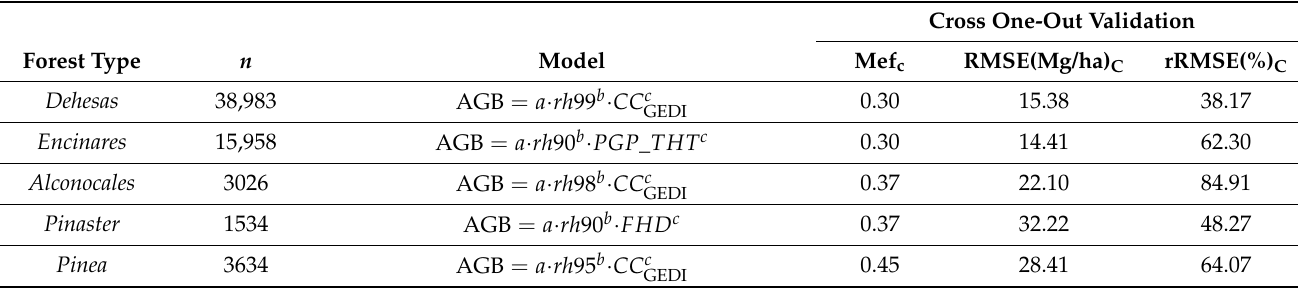
Table A2. Summary of absolute and relative RMSE for the GEDI calibrated model and LOOCV AGB predictions stratified by vegetation; n = number of observations per